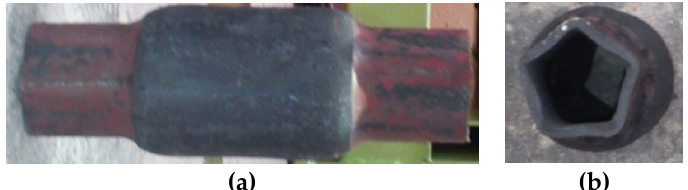
Figure 13. Deformation of the cross-section of the compressed steps, caused by excessive cooling of the material ( v / n = 0.5 mm / rotation s, δ = 1.5): ( a ) front forging view, ( b ) side forging view.